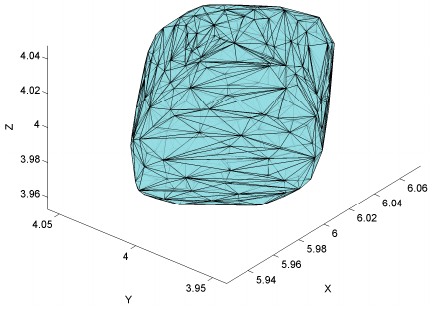
Figure 6. Convex hull of the points representing the solid.